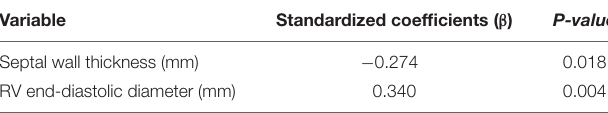
TABLE 4 | Multiple linear regression analysis for the association between plasma apelin levels and clinical characteristics in patients with obstructive hypertrophic cardiomyopathy.